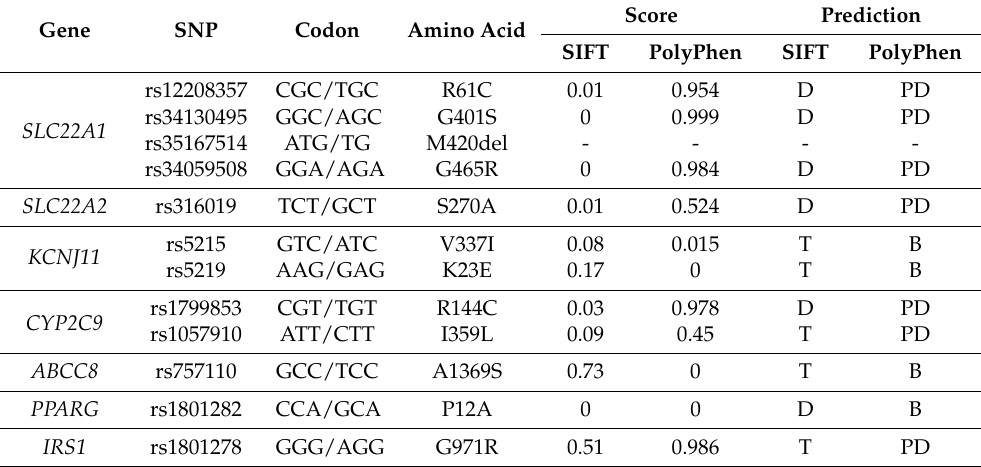
D = deleterious; T = tolerated; PD = probably damaging; B =